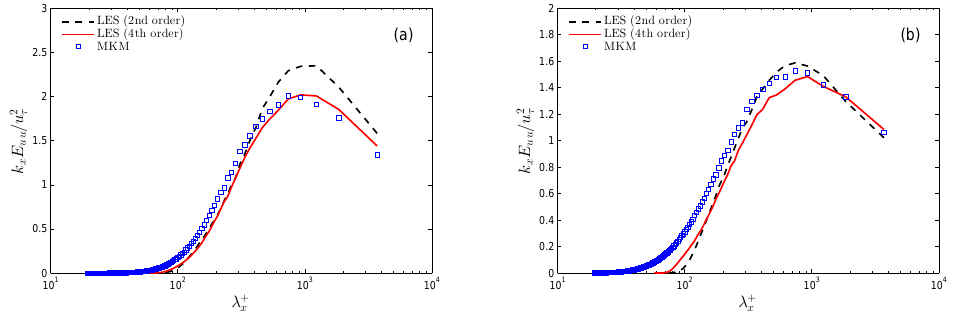
Figure 13. One-dimensional streamwise pre-multiplied spectra k x E uu at ( a ) y + ≈ 10 and ( b ) y + ≈ 30 of turbulent channel flow by LES at Re τ =